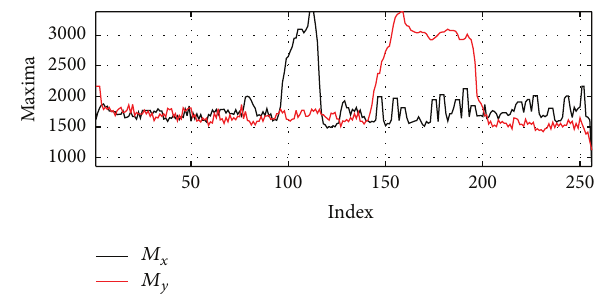
Figure 5: Plots of 𝑀 𝑥 (𝑦) and 𝑀 𝑦 (𝑥) calculated from TV-image shown in Figure 4.